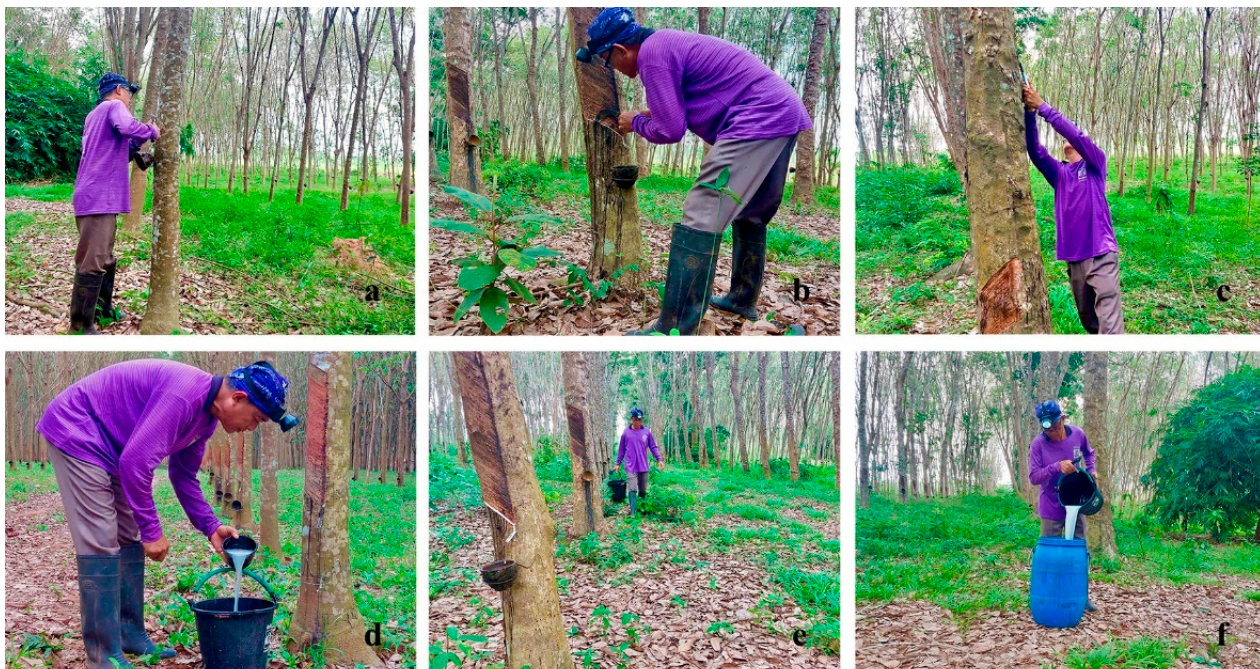
Figure 1. Illustrations of work postures during the harvesting process. ( a ) Body twisting along the angle of the trunk. ( b ) Bending down for rubber tapping in the low panel. ( c ) Reaching the trunk for the rubber tapping in the high panel. ( d ) Bowing down to harvest natural latex. ( e ) Lifting and moving heavy loads along the tree line. ( f ) Exerting force to support the latex bucket to pour it into a larger reservoir.